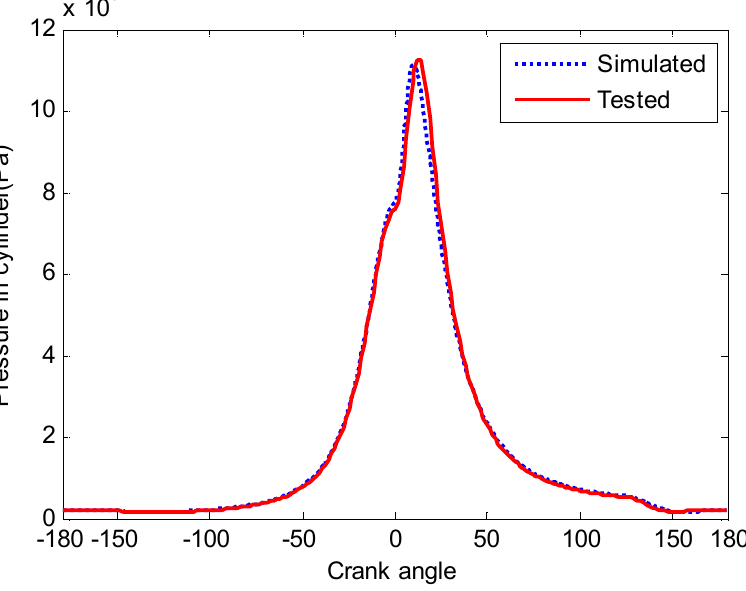
Figure 10. Indicator diagram of case 1. Energies 2019 , 12 , x FOR PEER REVIEW